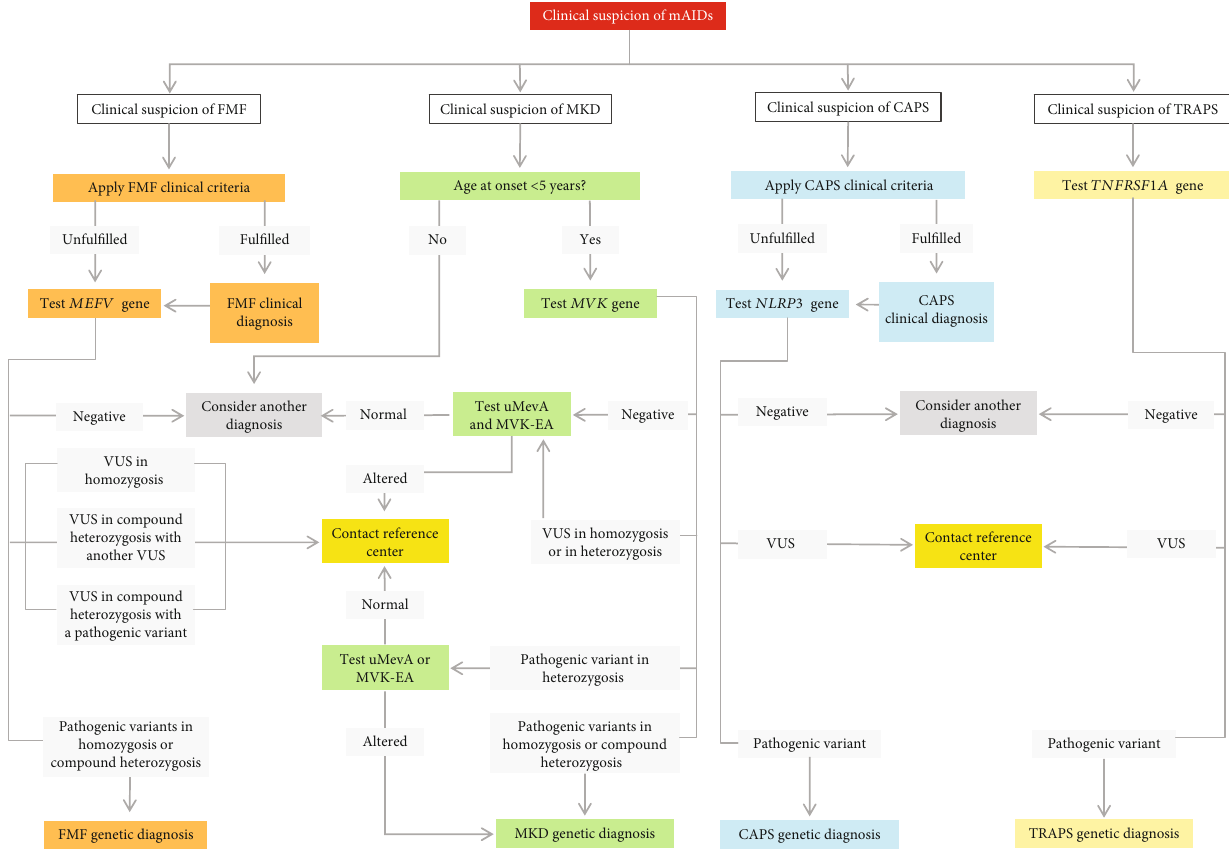
Figure 6: Genetic evaluation in patients with a suspicion of FMF, MKD, CAPS, and TRAPS. List of abbreviations: FMF — familial Mediterranean fever; MKD — mevalonate kinase de fi ciency; CAPS — cryopyrin-associated periodic syndrome; TRAPS — tumor necrosis factor receptor-associated periodic syndrome; uMevA — urinary mevalonic acid during fever; MVK-EA — mevalonate kinase enzyme activity; VUS — variant of unknown signi fi